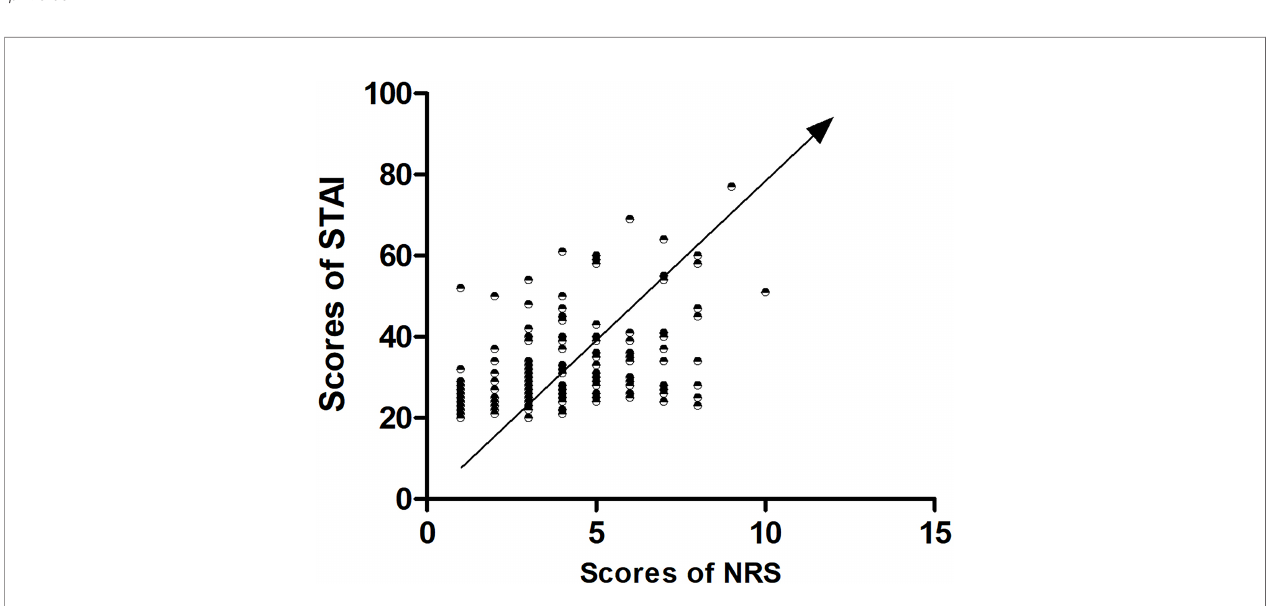
FIGURE 2 | Correlation between NRS and STAI.